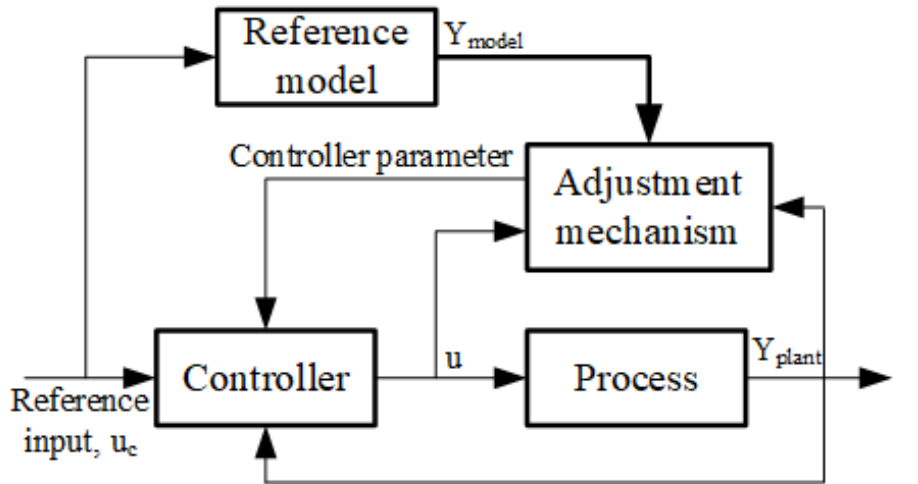
Figure 6. Model reference adaptive control